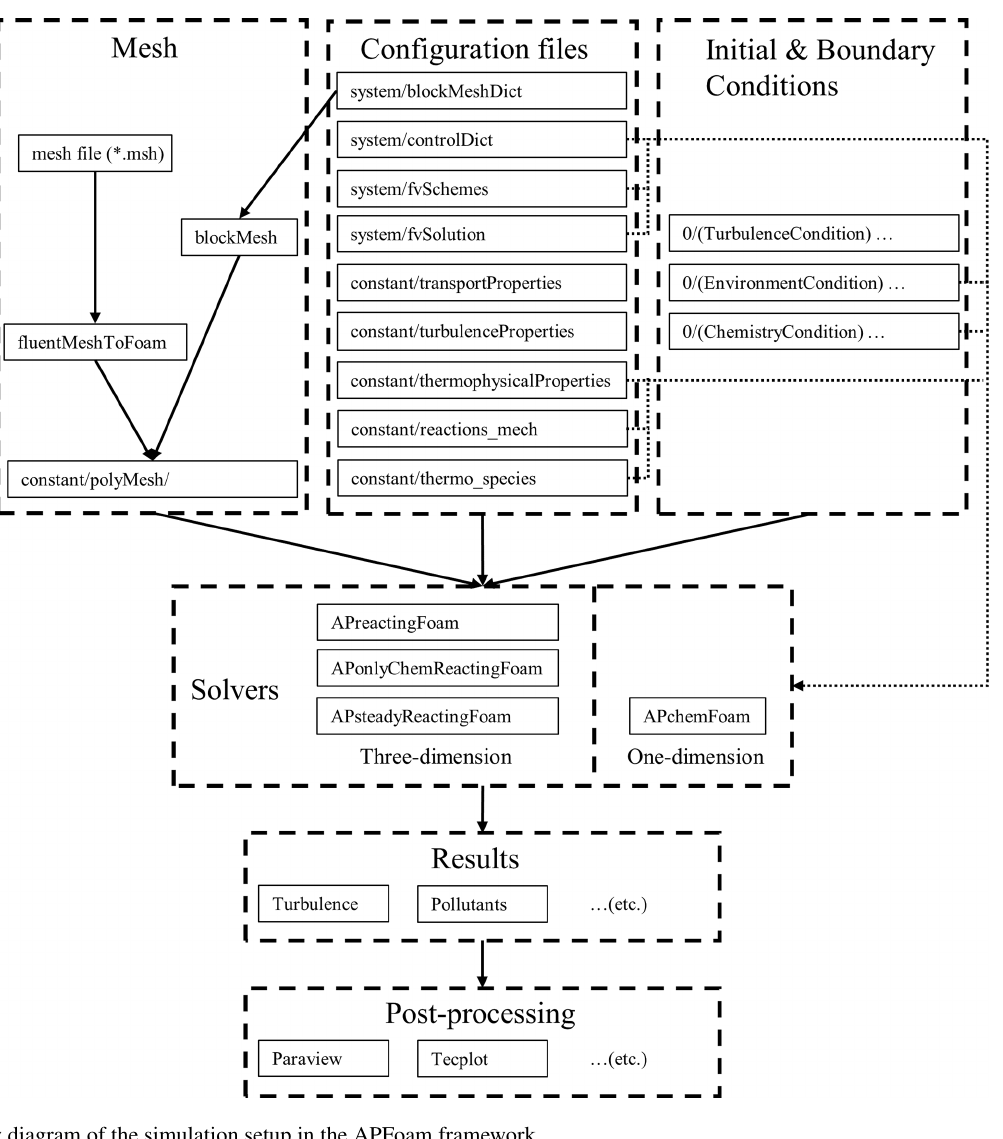
Figure 1. Flow diagram of the simulation setup in the APFoam